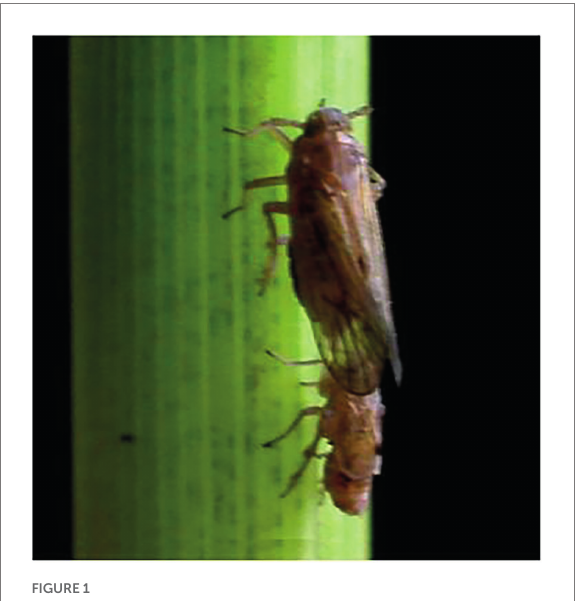
FIGURE 1 Nilaparvata lugens